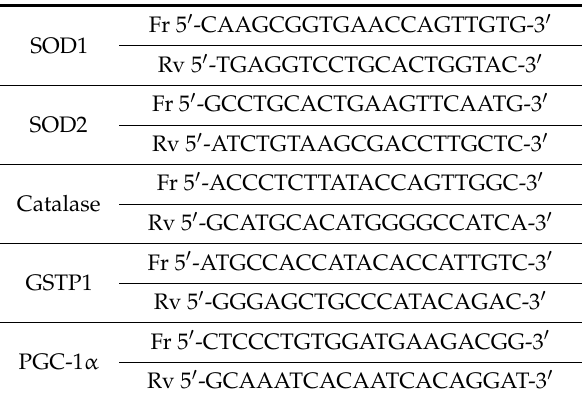
Table 3. qRT-PCR primers for antioxidant defense